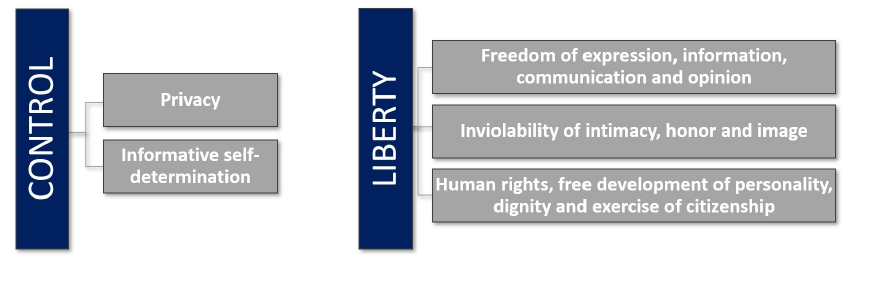
Figure 1. Constitutive elements of the privacy concept according to